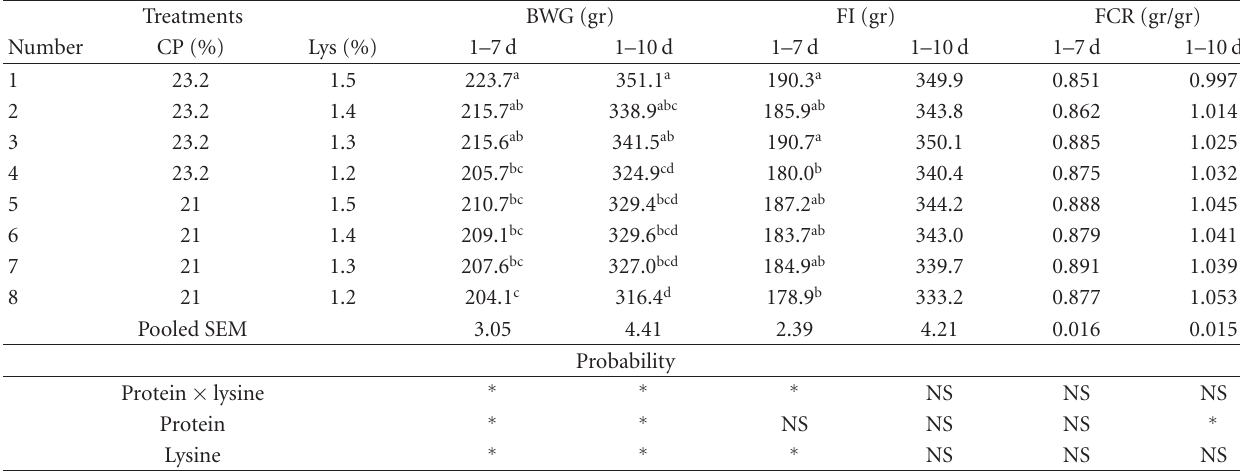
Table 3: E ff ect of feeding diets containing various levels of crude protein (CP) and lysine (Lys) on body weight gain, feed intake, and feed conversion ratio of broiler chicks (Experiment 1-1).